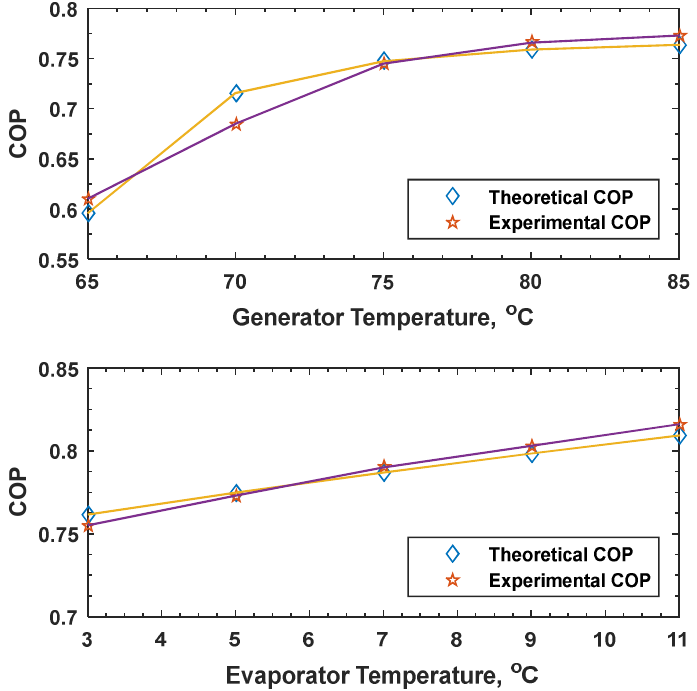
Figure 14. Validation of absorption chiller model.